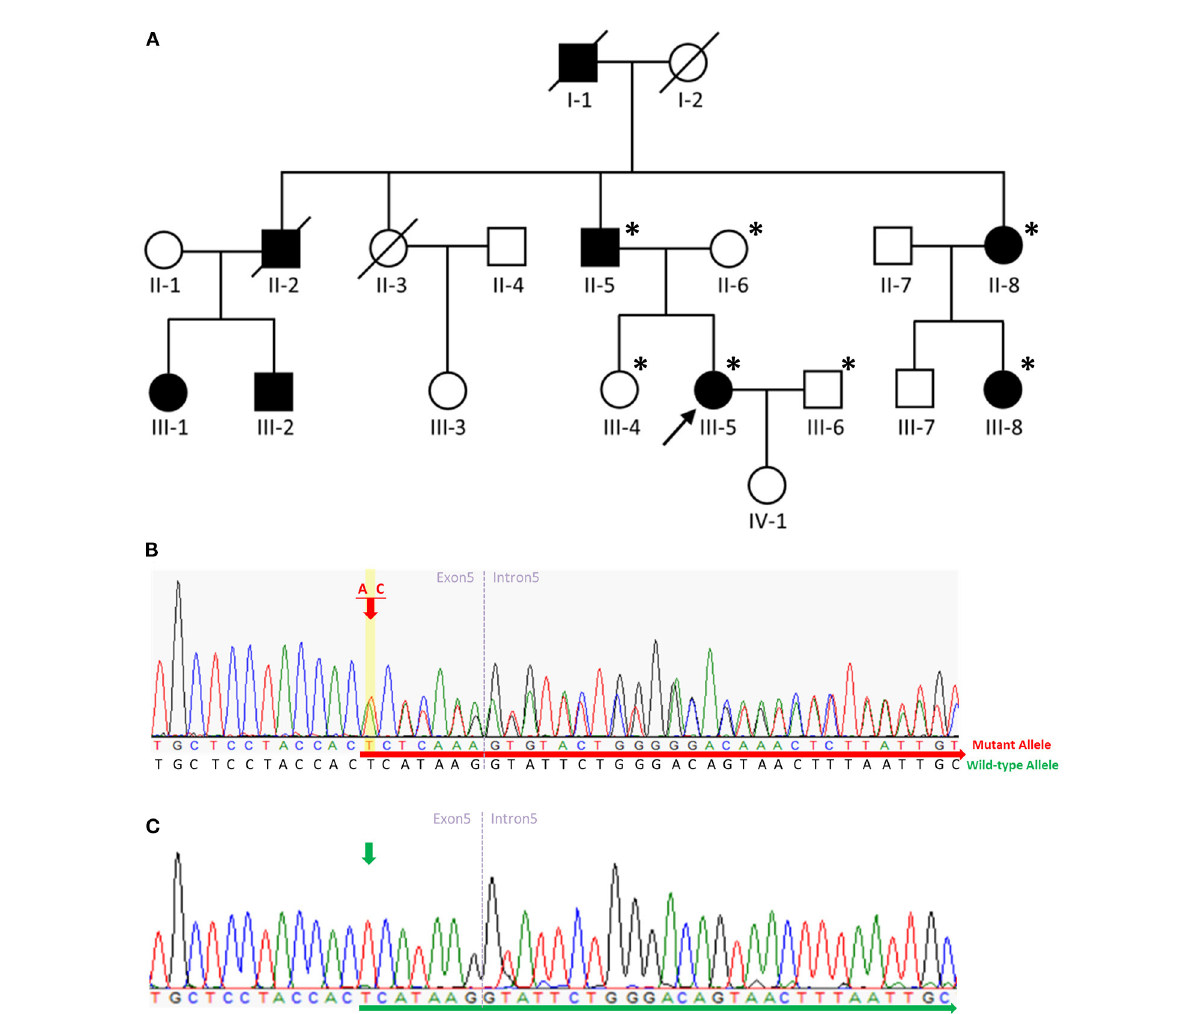
FIGURE2 Pedigree of the SPG4 family and sequence analysis. (A) The proband is indicated (arrow). Squares indicate males; circles, females; slashes, deceased individuals; black symbols, individuals with symptoms of HSP; and unshaded symbols, individuals without symptoms of HSP. Patients evaluated clinically and genetically are each denoted by an asterisk. (B) Sequence analysis revealed a c.862_863dupAC frameshift variant in exon 5 of SPAST in the proband, her father, aunt, and aunt’s daughter. The red arrow indicates the c.864 nucleotide. (C) Sequence analysis revealed no variant in exon 5 of SPAST in the proband’s mother, husband, or sister. The green arrow indicates the c.864